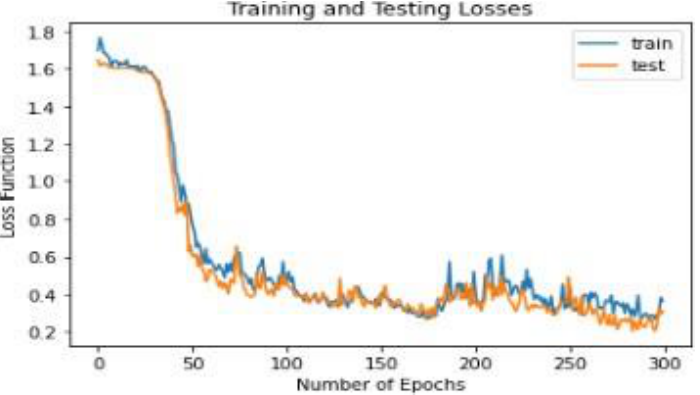
Figure 6. Number of Epochs vs. Loss function for Kannada dataset.